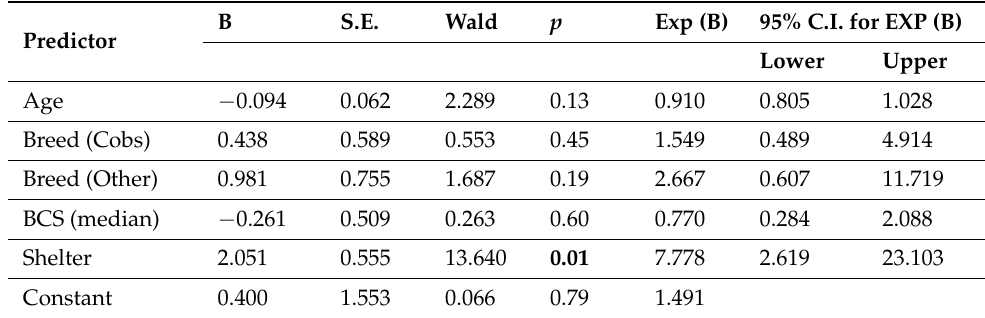
Table 6. Binomial logistic regression predicting likelihood of horse tethering (0 = absent, 1 = present), ( n = 104). Significant results are bolded ( p < 0.05), degrees of freedom =